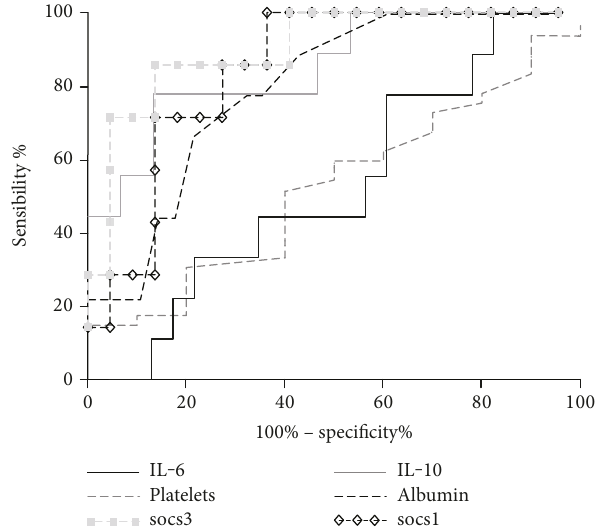
Figure 4: Predictive analysis of immunological biomarkers to identify dengue severity. The ROC curves were plotted using the sensitivity and speci fi city data and the cuto ff values presented in Table 3, with the software GraphPad Prism 5. soc3, socs1, IL-10, and albumin discriminate between DF and